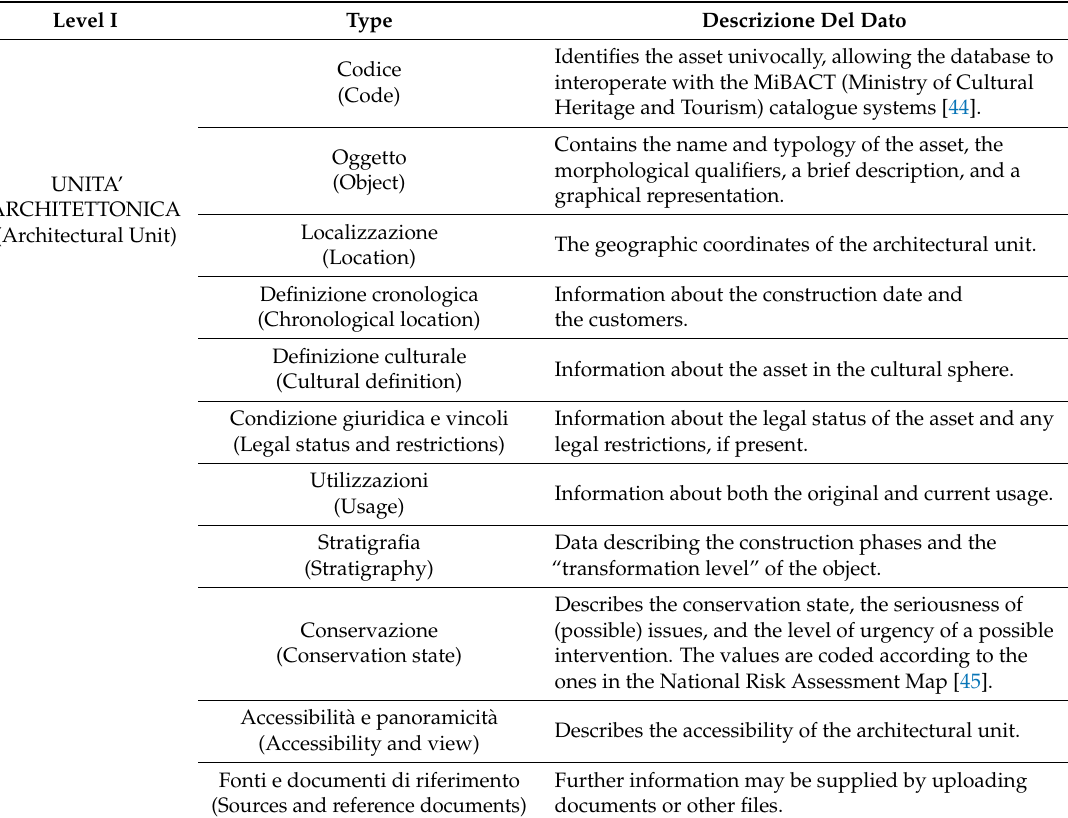
Table 1. Architectural Unit